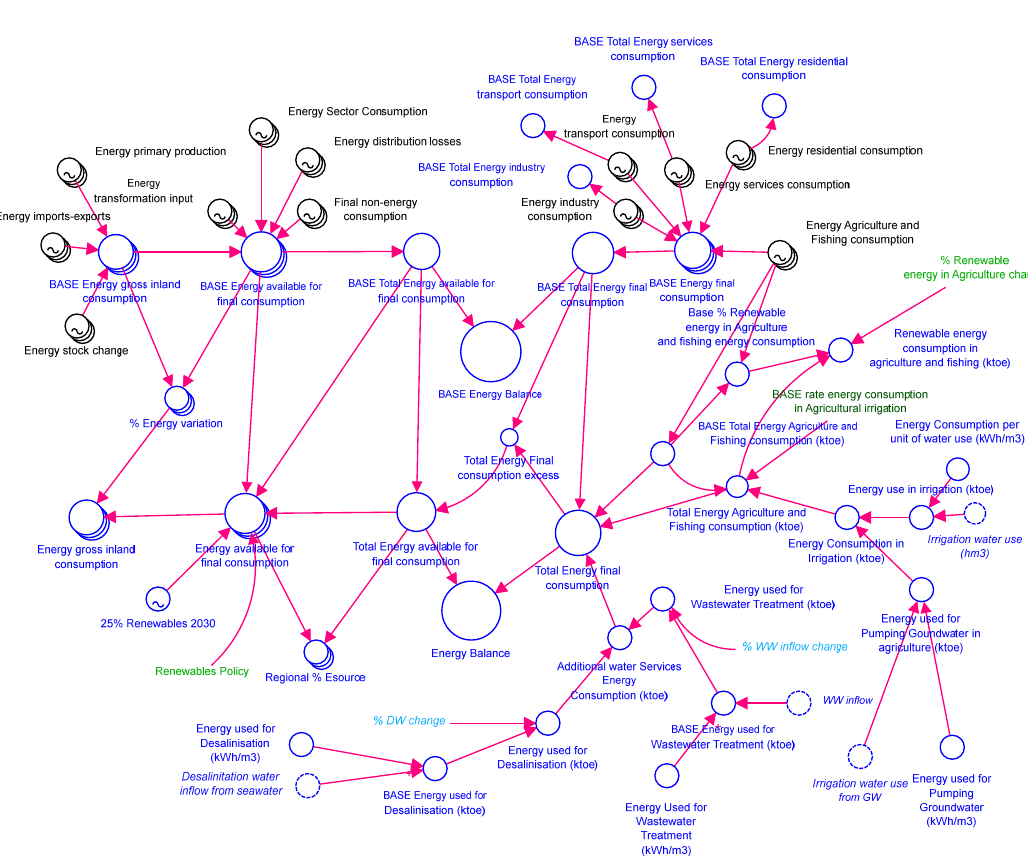
Figure 5. Energy sector representation in the system dynamics model. Source: our own elaboration.